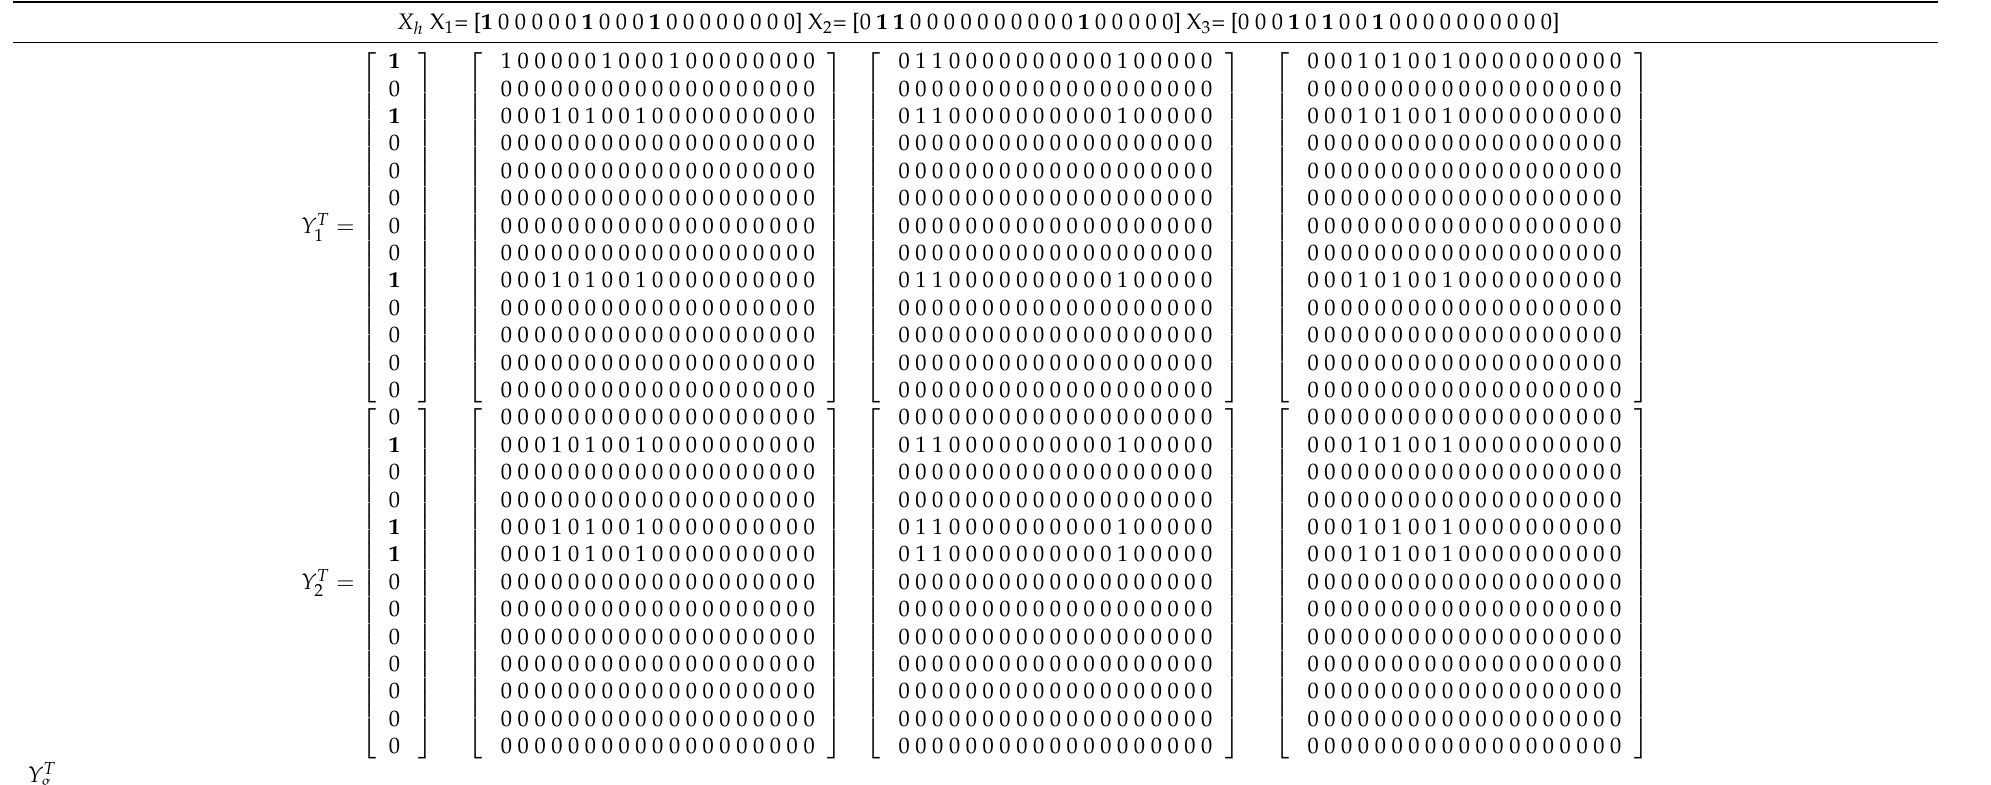
Table 2. Example of 2D-BIBD code sequences with ( w 1 = 3, N max = 2 and w 2 = 3, N (cid:48) max =